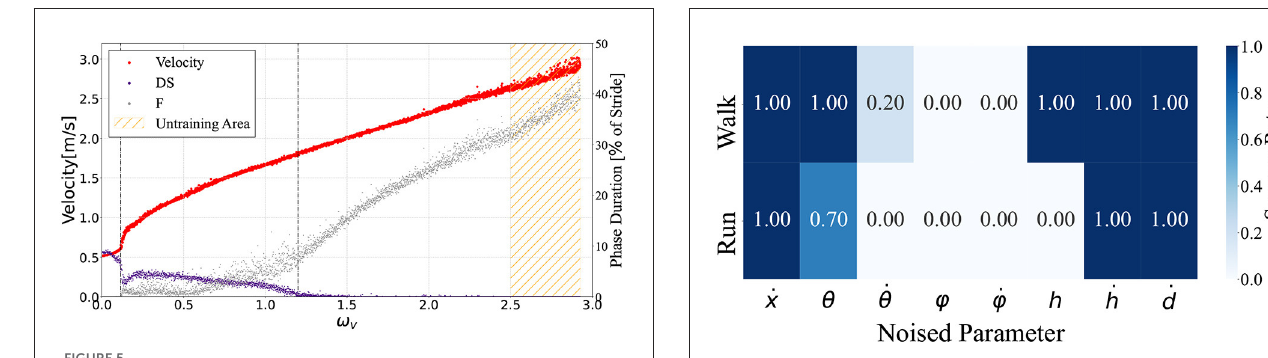
FIGURE6 The rate of steady gait was maintained when noise was applied. x , θ , ˙ θ , ϕ , ϕ , h , ˙ h , ˙ d are the input parameters for the controller. For each ˙ ˙ of these seven states, we added Gaussian noise during steady walking and running and checked whether the bipedal model maintains the gaits. We conducted 10 locomotion trials for each condition and judged the success case when the bipedal model was able to move 10m in the walking gait and 20m in the running gait after noise was applied.